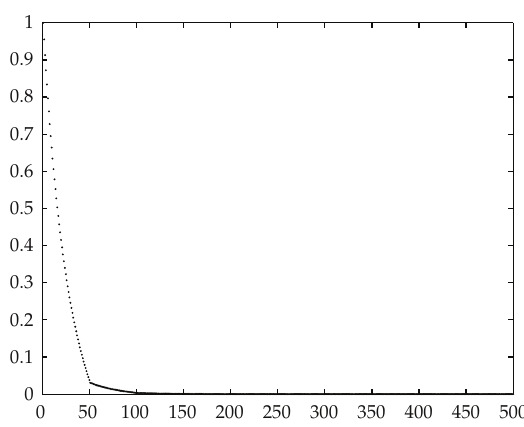
Figure 6: Linear θ -method with θ (cid:6) 1 for (cid:4) 5.3 (cid:5)